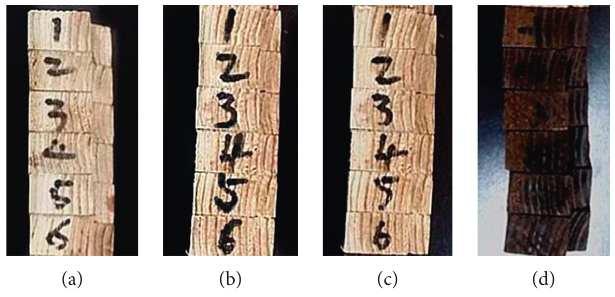
Figure 8: Effect of temperature on the wood color: (a) room temperature; (b) 100 ° C; (c) 200 ° C; (d) 250 °